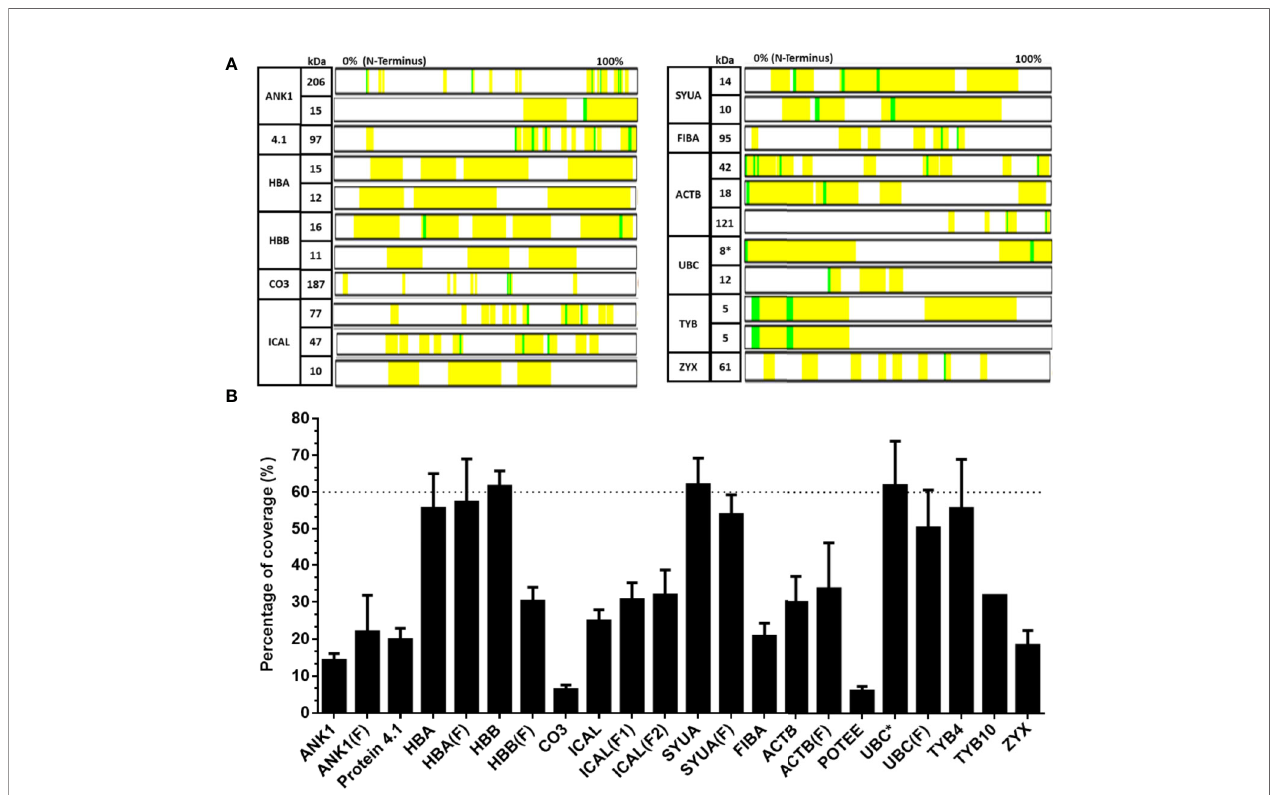
FIGURE 3 | Analysis of the percent coverage of the proteins that consistently provide peptides to Transferon. The proteins that consistently provide peptides to Transferon were individually analyzed, and their total contribution was reported as the percent of coverage. (A) The map of the peptides found in the sequencing analysis of batch 14G18 is showed as an example; the identi fi ed peptides are marked in yellow and in green chemical modi fi cation. Note that the length of the proteins was normalized and does not represent its real size. (B) Average percentage coverage per protein obtained in the 10-batch sequencing analysis. The average percent of coverage of HBB, SYUA and monomer UBC was 61.6, 62.0, and 62.2%, respectively. The bars indicate the SD of the 10-batch analysis. C-, cluster; (F), fragment; *, monomer; ankyrin (ANK-1), hemoglobin subunit a (HBA), hemoglobin subunit b (HBB), complement C3 protein (CO3), calpastatin (ICAL), a -synuclein (SYUA), fi brinogen a -chain (FIBA), cytoplasmic actin 1 (ACTB), POTE ankyrin domain family member E (POTEE), polyubiquitin C (UBC), thymosin b 4 (TYB4), thymosin b 10 (TYB10), and zyxin